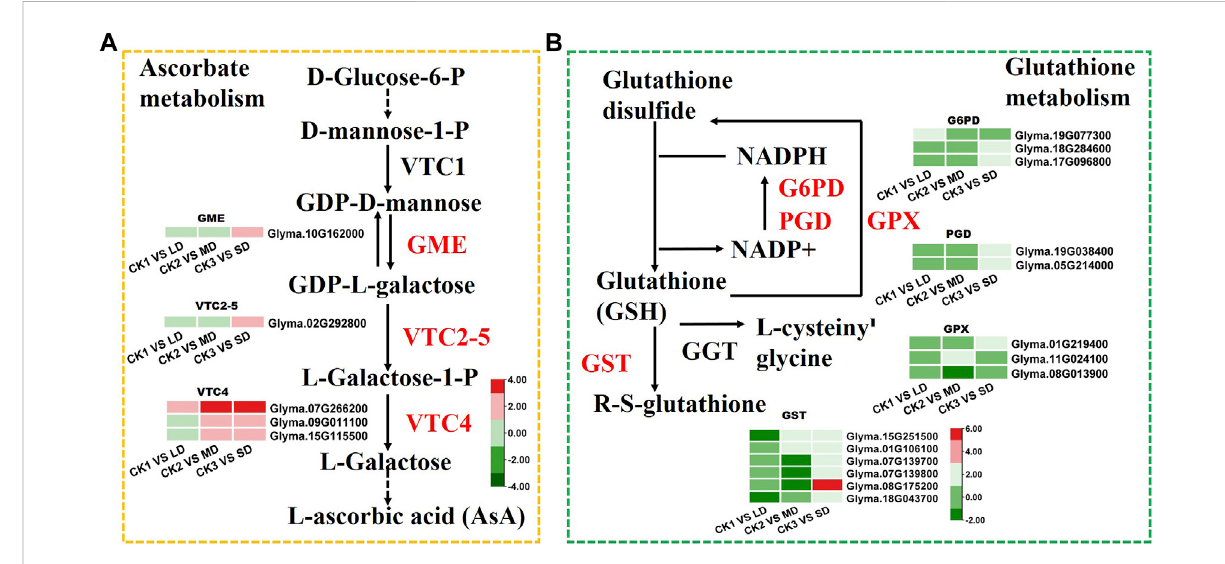
FIGURE 6 Heatmap of the DEGs involved in ascorbate and glutathione metabolism in response to drought stress. (A) The DEGs involved in ascorbate metabolism. (B) The DEGs involved inglutathionemetabolism.The colors of heatmap vary from green to red bynormalizingthelog 2 (FPKM) of each